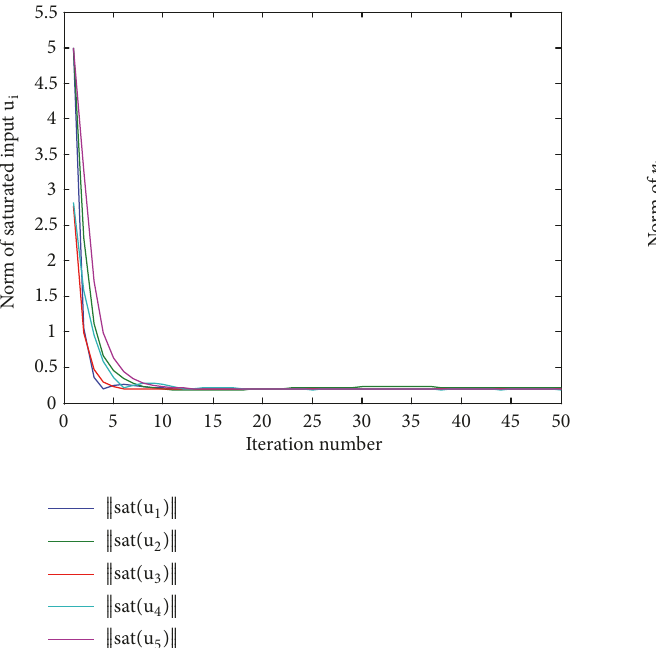
Figure 4: Norm of saturated inputs.